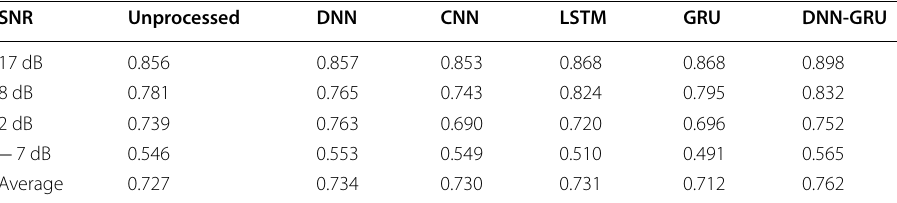
Table 4 Average STOI results among five models under mismatch input SNRs